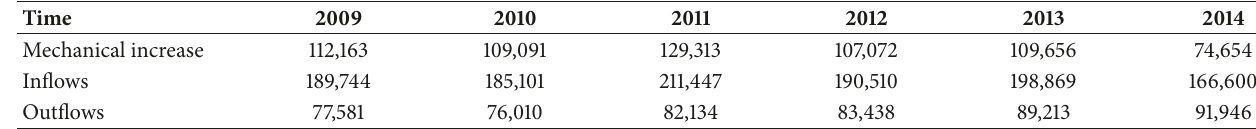
Table 2: Historical values of main correlated variables. Unit: person.